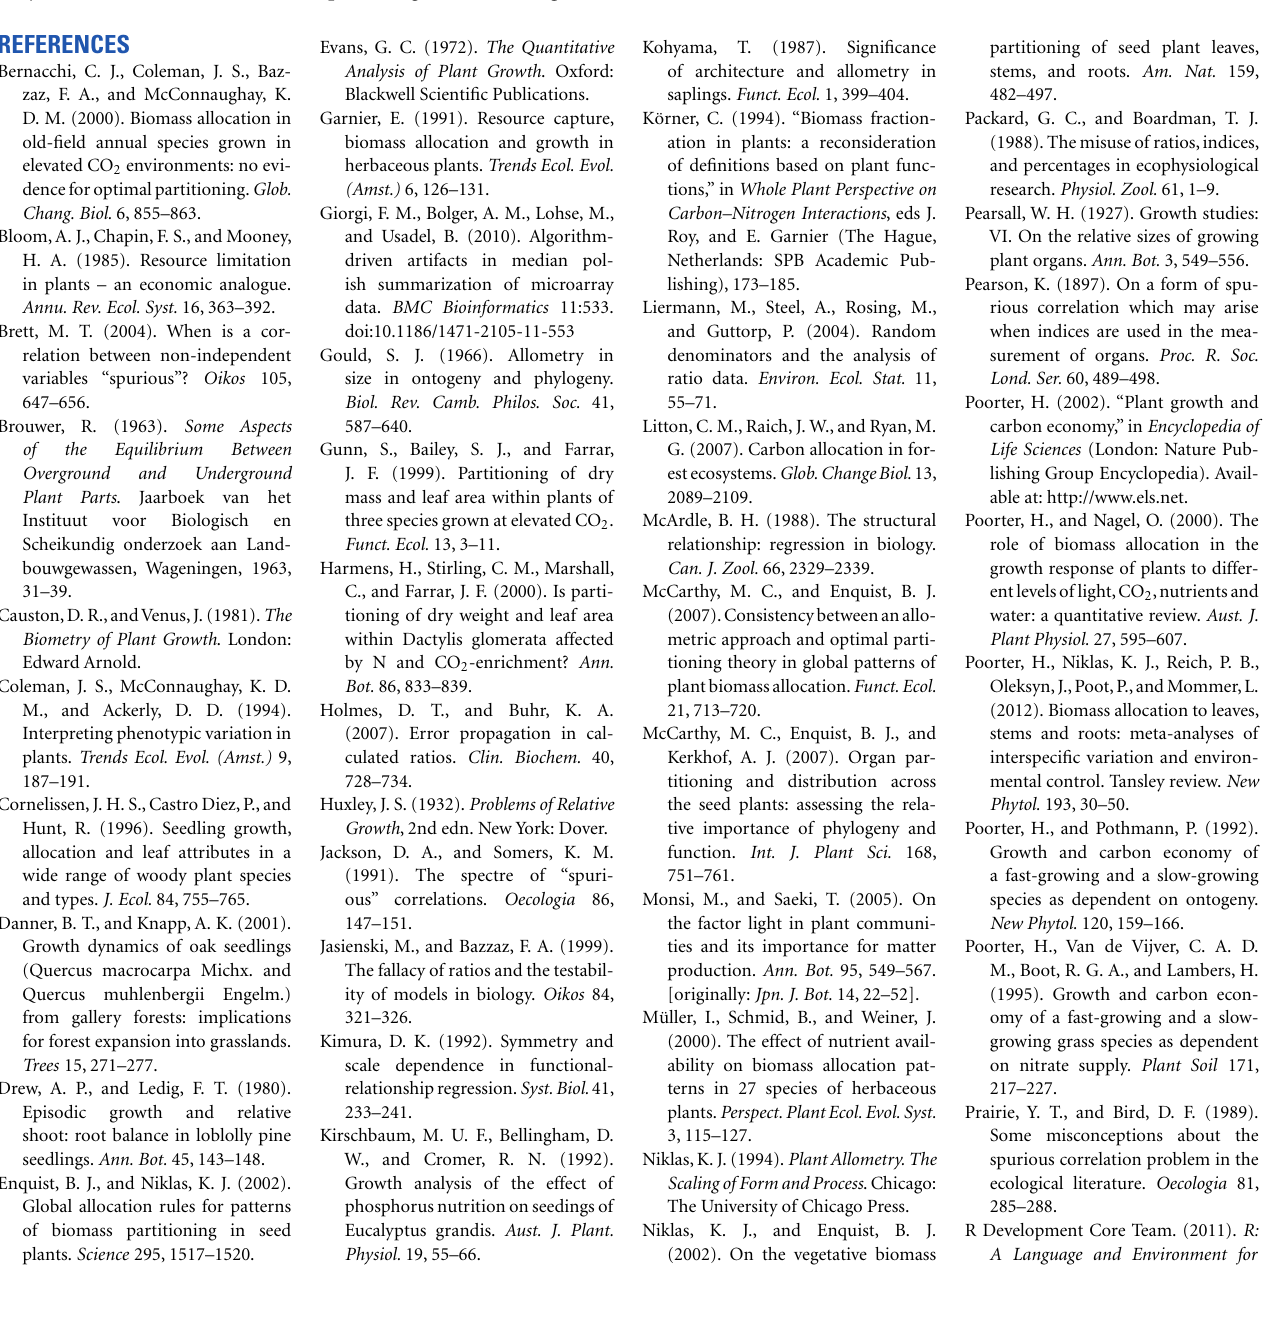
Table S1 |AllometricAlgebra. The effect of OLS and SMA fitting in the case where allometries are algebraically